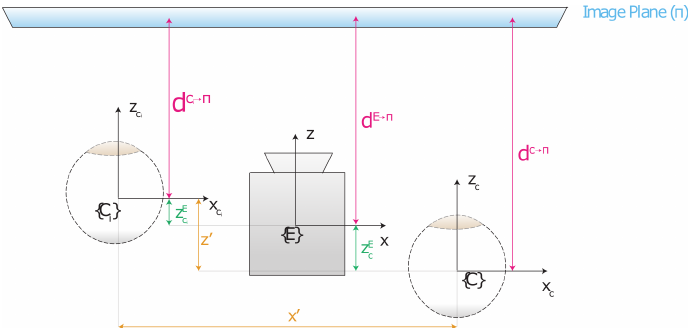
Figure 3. The x-z plane of off-axis pinhole model with the rendering camera and the eye in two different